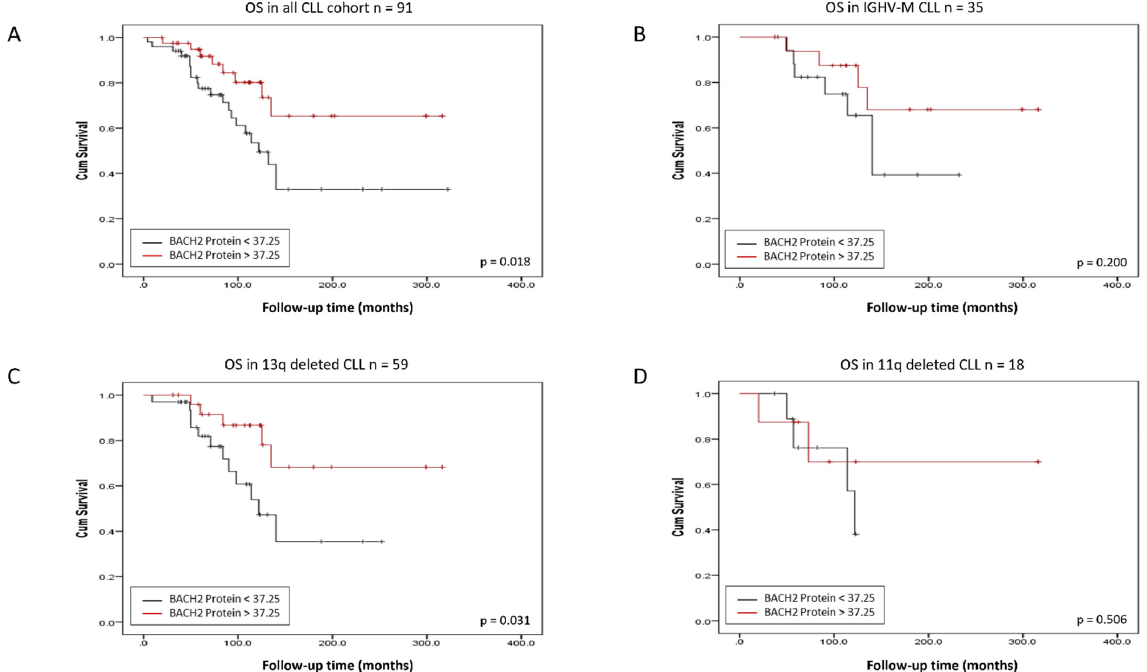
Figure 4. Kaplan–Meier analysis of CLL patients stratified by BACH2 protein expression. BACH2 protein low expression predicts shorter overall survival in all cohorts ( A ) and in 13q-deleted ( C ), but not in immunoglobulin heavy chain variable region-mutated (IGHV-M) patients ( B ) or 11q-deleted subgroups ( D ).